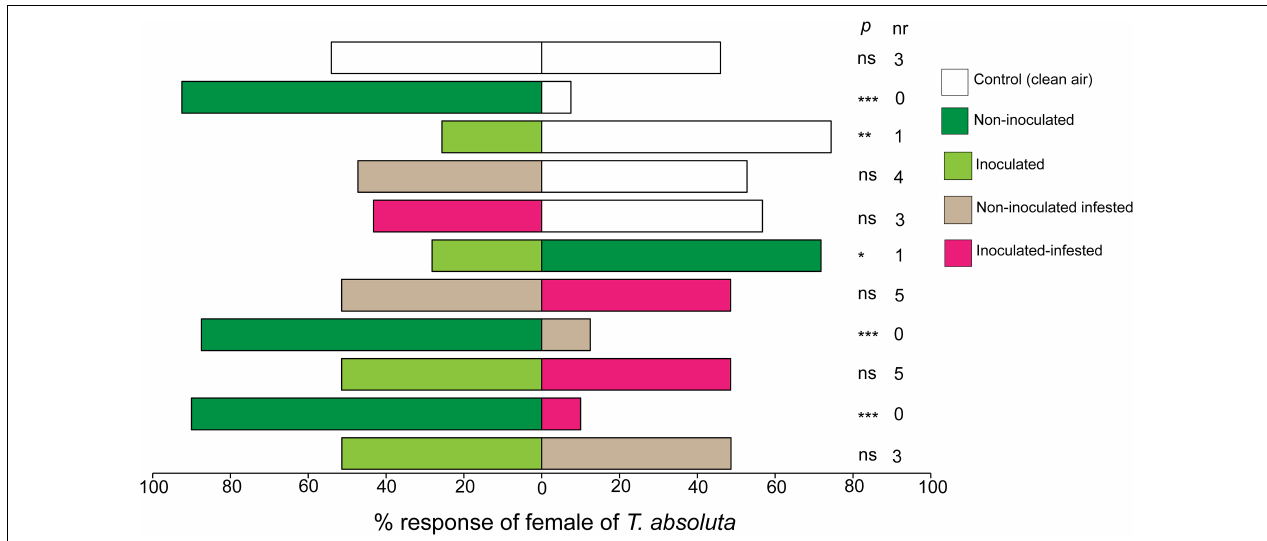
FIGURE 2 | Responses (%) of females of Tuta absoluta to volatiles from non-inoculated, inoculated, non-inoculated infested, and inoculated infested tomato plants in a Y-tube olfactometer choice test. nr, number of non-respondent insects (i.e., no choice). P stands for statistical significance levels with ns, no significant